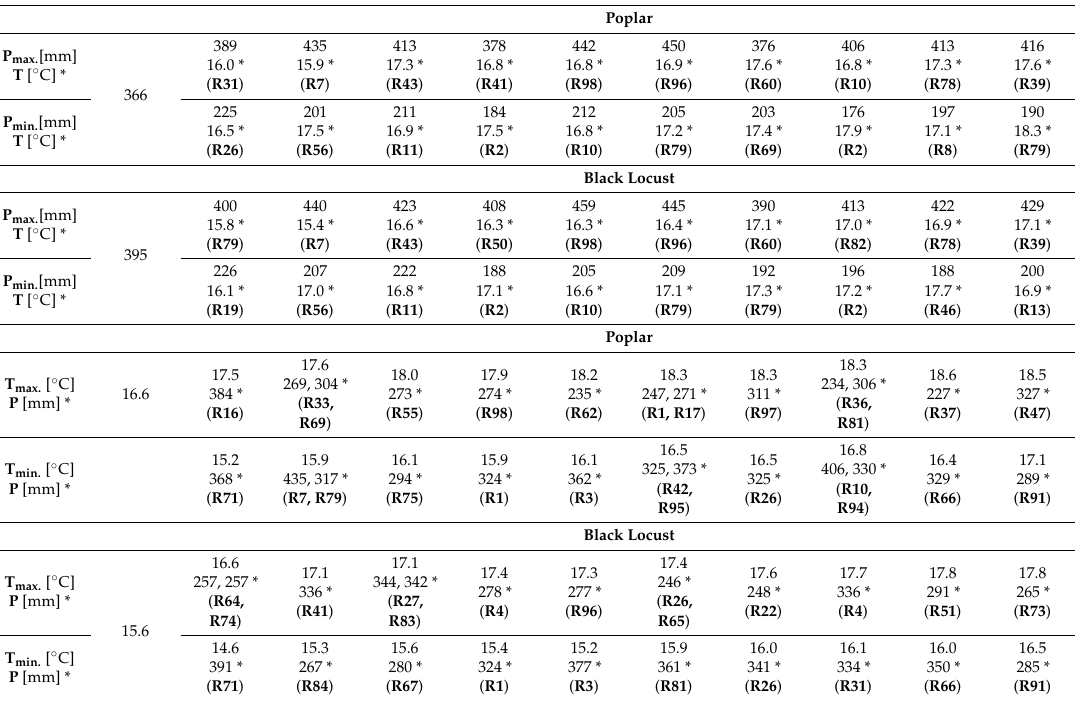
Table A2. Realisations (R, highlighted in parentheses) that rendered minimum and maximum average precipitation (P min , P max ), air temperature (T min , T max ), and global radiation (R min , R max ) values in the established ten growing periods with respect to the vegetation period of both tree species. The reference periodfor poplar(2011–2014)and blacklocust(2010–2013) trees accounted fortheirdistinct vegetationperiod. Average